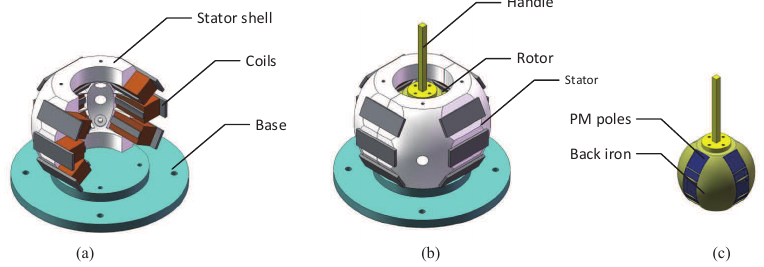
Figure 1. Structure of FSS with spherical actuator. ( a ) stator; ( b ) overview construction; ( c )